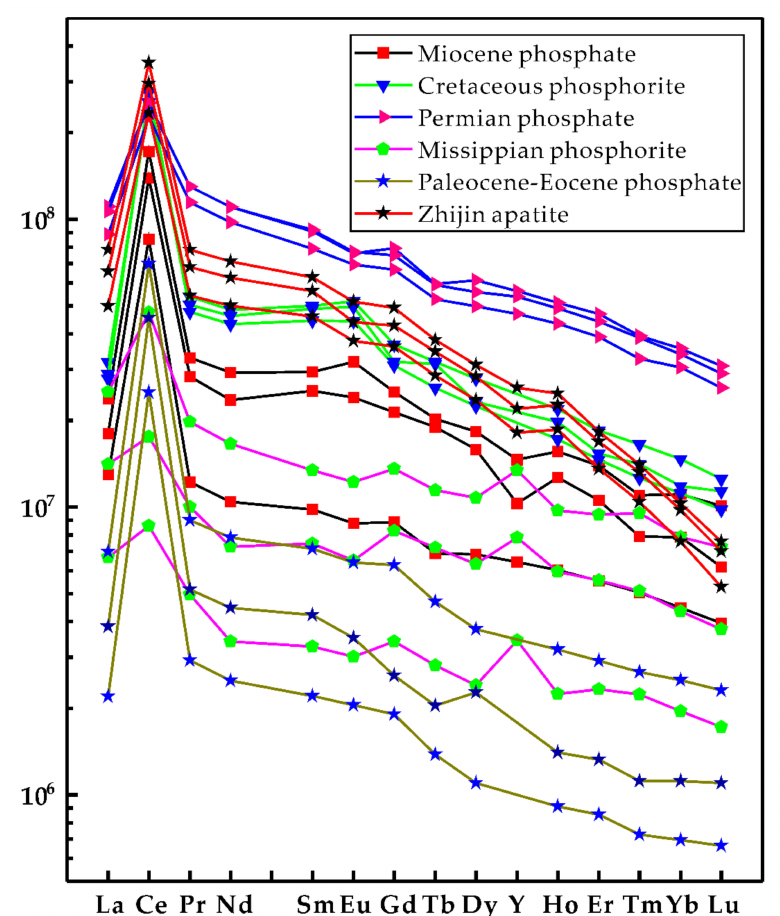
Figure 9. Seawater-normalized REY patterns of the intraclastic apatite of di ff erent ages’ phosphate or whole rock: Zhijin apatite (study area), Upper Cretaceous phosphorite (Egypt), Upper Permian phosphate (Montana, US.), Miocene phosphate (Florida, US.), Middle Mississippian phosphorite (Alaska, US.), Paleocene-Eocene phosphate (Tunisia) [2].